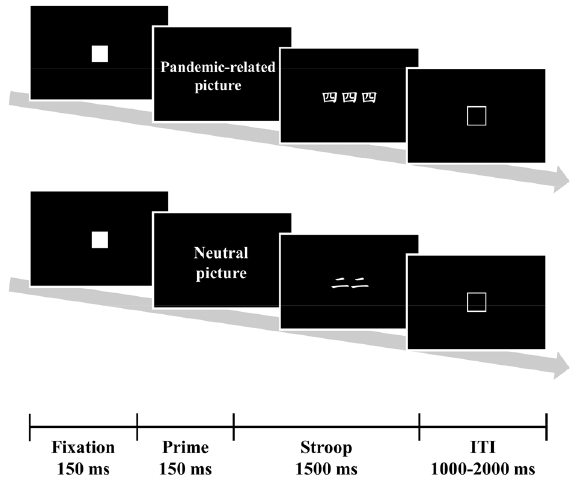
Figure 1. Experimental design of the emotional counting stroop task.